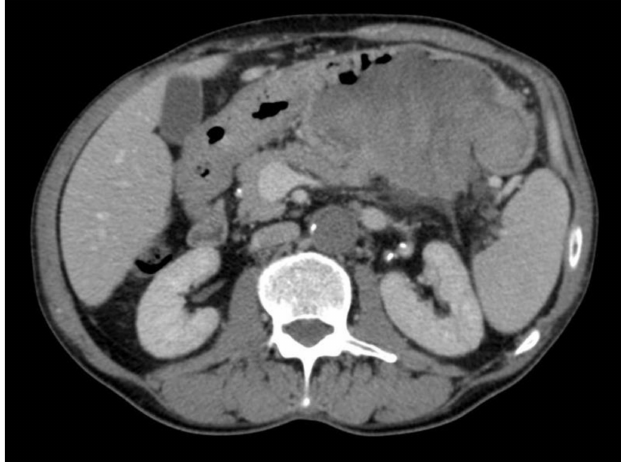
Figure 2. Gastric lesion in the venous